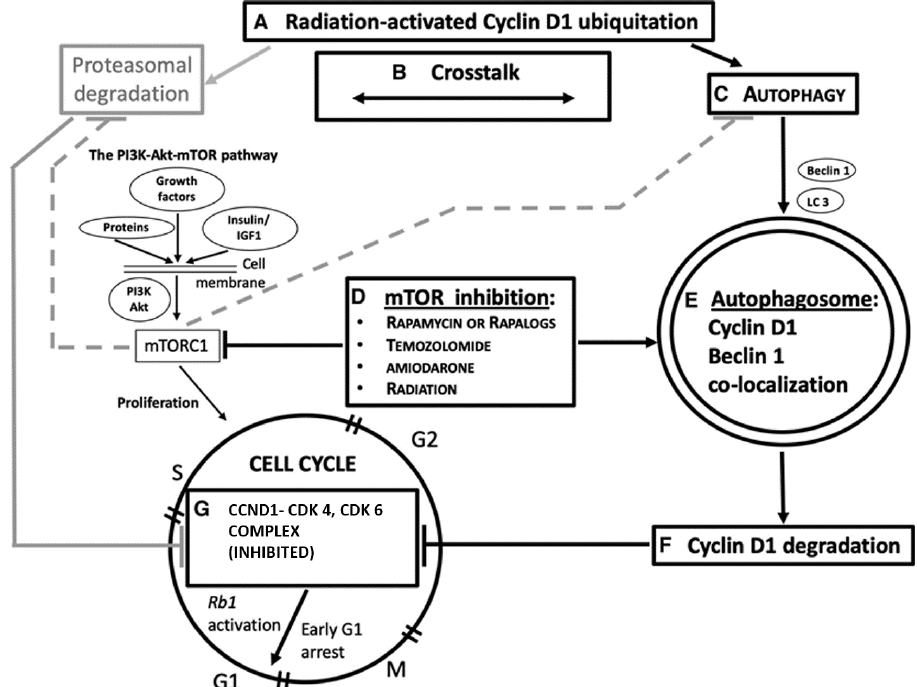
Figure 3. A simplified overview of the role of autophagy and Beclin-1 in CCND1 degradation, as a possible mechanism actionable for G 1/S cell cycle arrest in cancer. Radiation and chemotherapy are also considered in this domain. Some steps of the pathway are indicated, as shown in different tu-